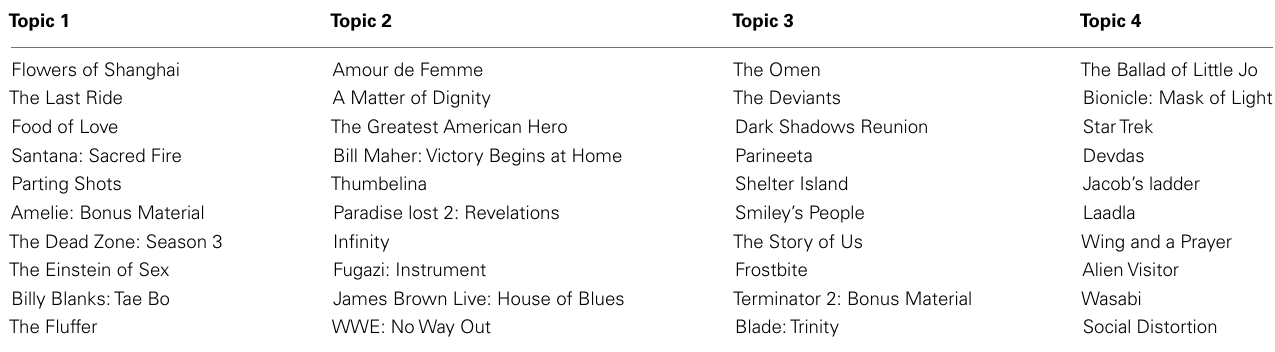
Table 9 | Selected topics.